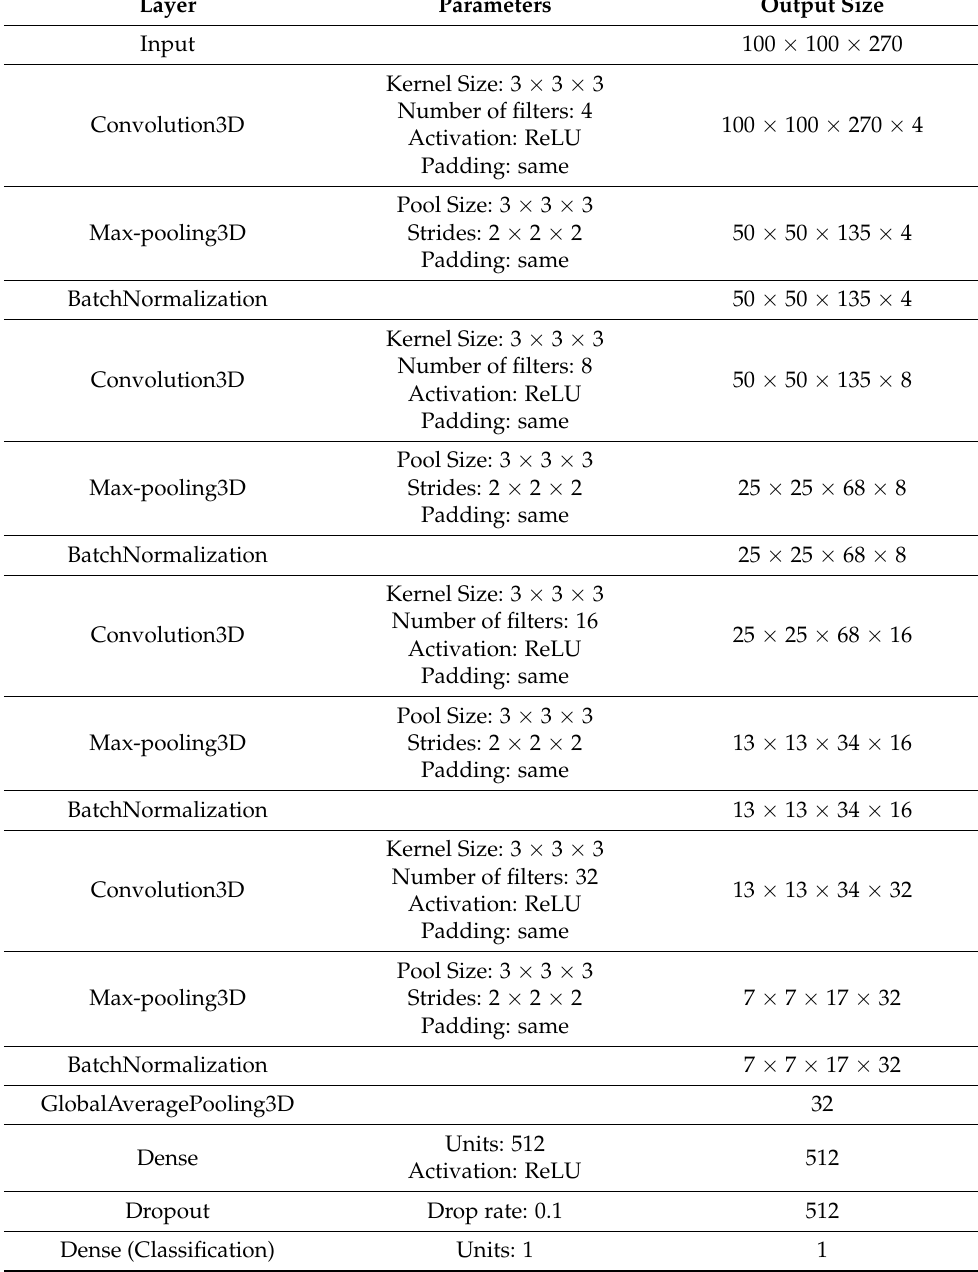
Table 1. 3D-CNN Topology with